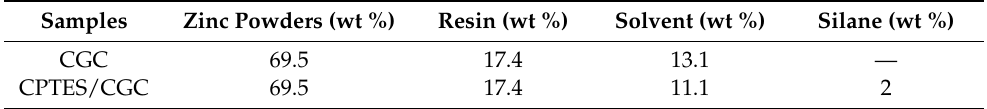
Table 1. Formulation of cold galvanizing